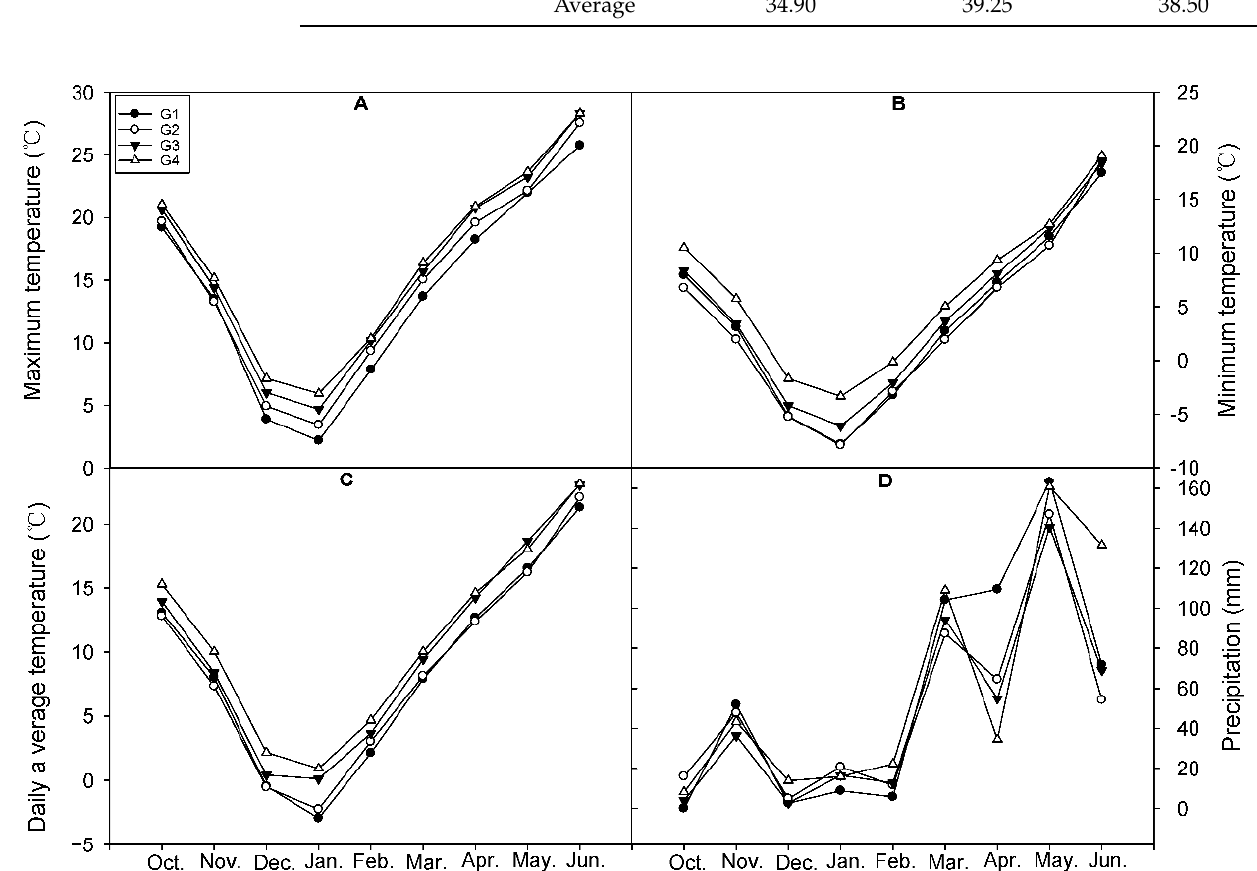
Figure 2. Maximum ( A ), minimum ( B ), daily average temperatures ( C ), and precipitation ( D ) in different group areas during experiment period in October 2020 to June 2021.